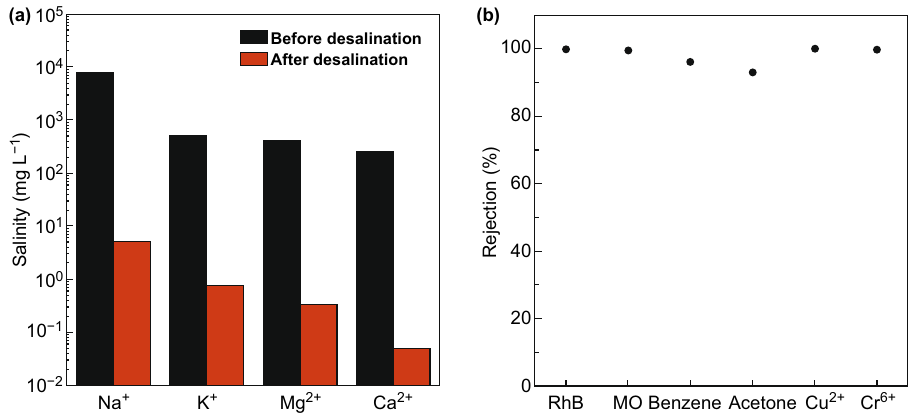
Fig. 14 a Measured salinity of four primary ions before and after solar desalination. b Organic and heavy metal ion rejection performance. Reprinted with permission from Ref. [72]. Copyright © (2019) Royal Society of